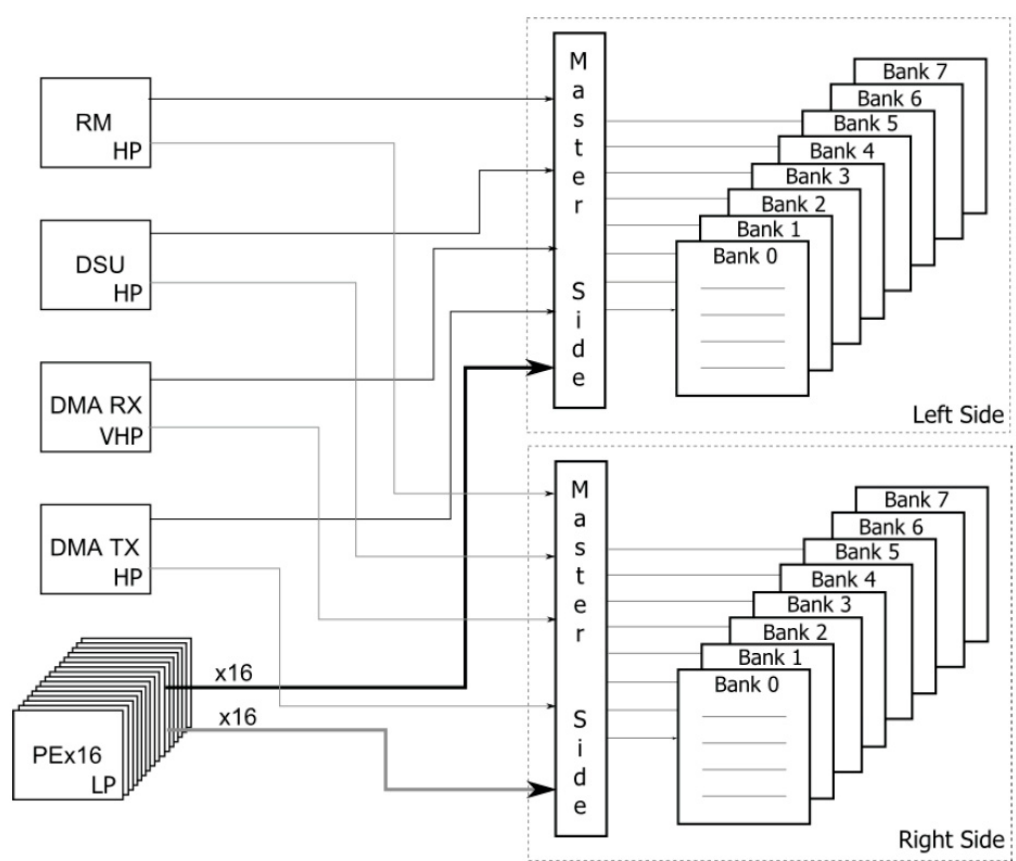
Figure 2. Compute cluster bus masters [31].